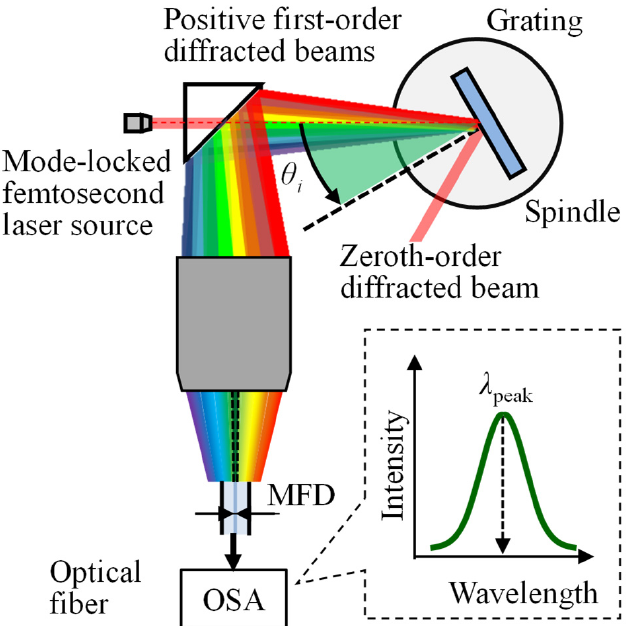
Figure 2. Peak wavelength detection for measurement of the grating pitch.